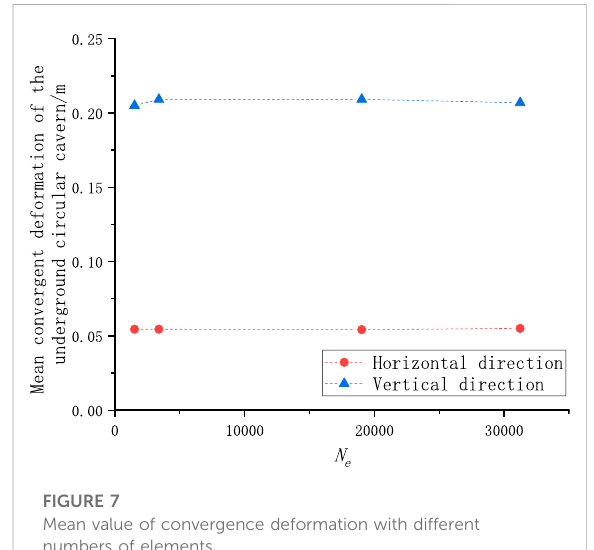
FIGURE 7 Mean value of convergence deformation with different numbers of elements.